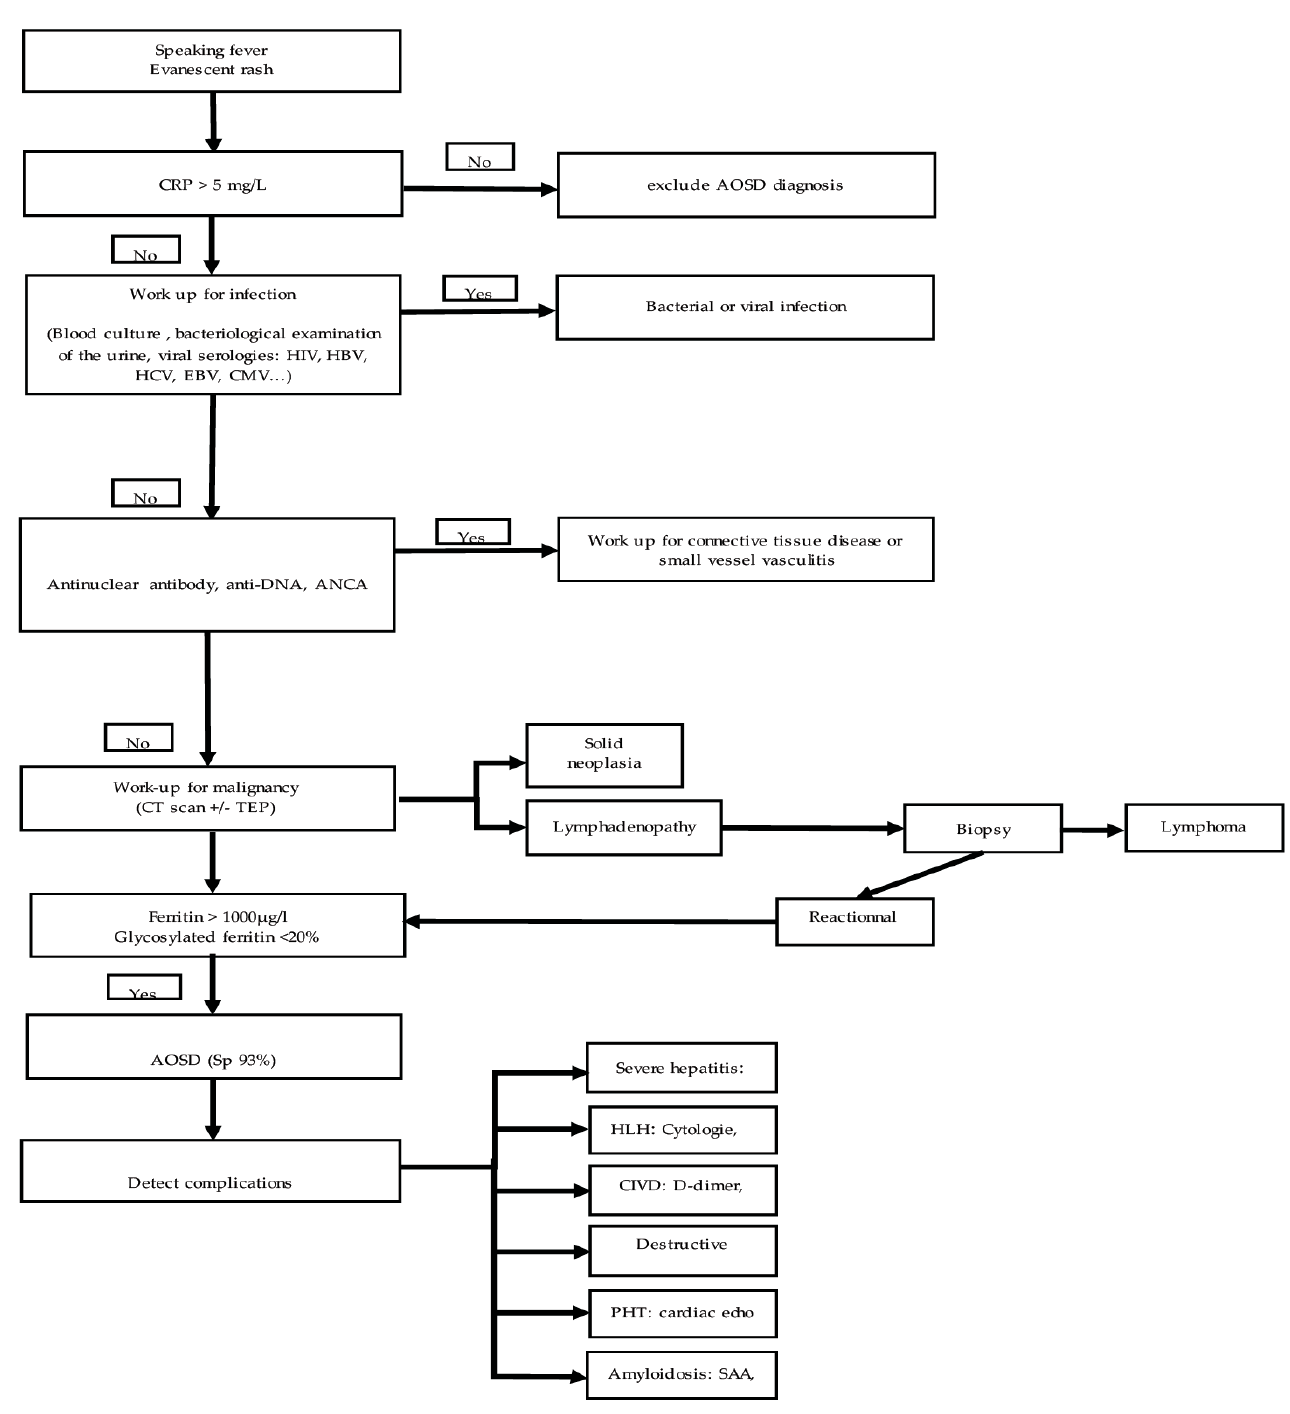
Figure 1. Proposal for stratification of complementary examinations in the presence of a clinic suggestive of Still’s disease. Legend: AOSD, adult-onset Still’s disease; HIV, human immunodeficiency virus; HBV, hepatitis B virus; HCV hepatitis C virus; EBV, Epstein–Barr virus; CMV, cytomegalovirus; ANCA, anti-neutrophil cytoplasmic autoantibody; TAP-Scan, thoraco-abdominopelvic scan; PET-Scan, positron emission tomography scan; ADP, adenopathy; HSMG, hepatosplenomegaly; PT, prothrombin time; HLH hemophagocytic lymphohistiocytosis; Tg, triglycerides; Fg, fibrinogen; DIVC, disseminated intravascular coagulation; TMA, thrombotic microangiopathy; Rx, radiography; US, ultrasonography; MRI, magnetic resonance imaging; PHT, pulmonary hypertension; SAA, serum albumin A.